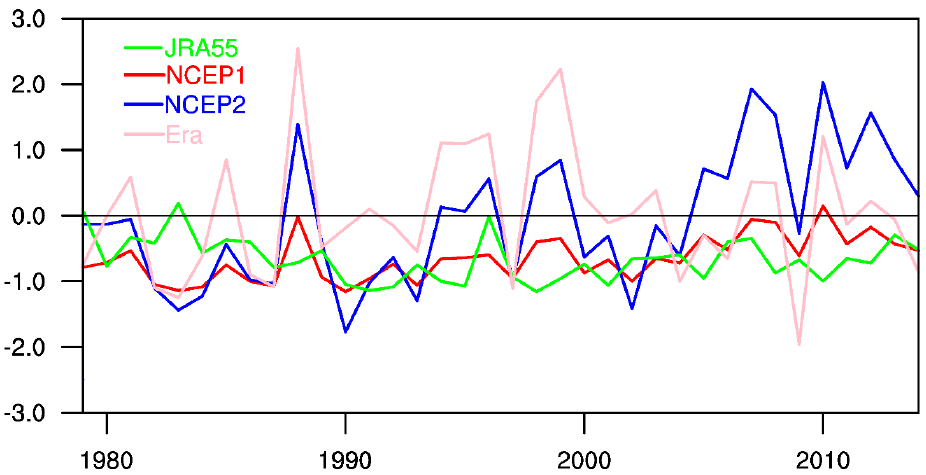
Figure 10. Time series of the standardized anomaly of the WASMI generated using different